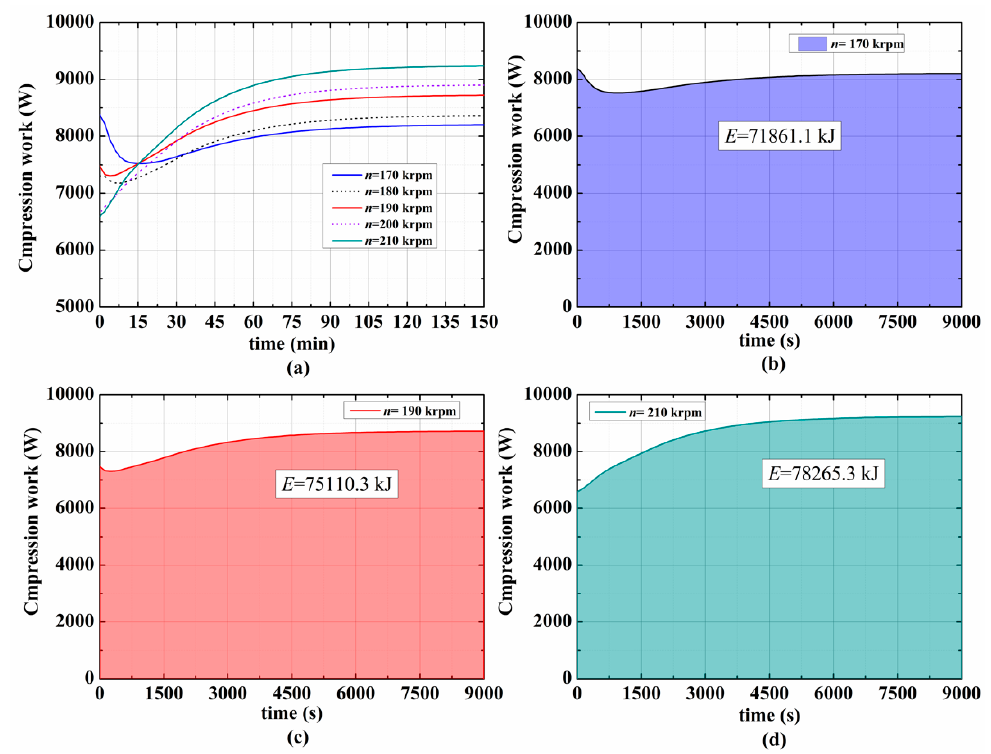
Figure 10. Compression work and total energy: ( a ) Under different rotating speed; ( b ) total energy at